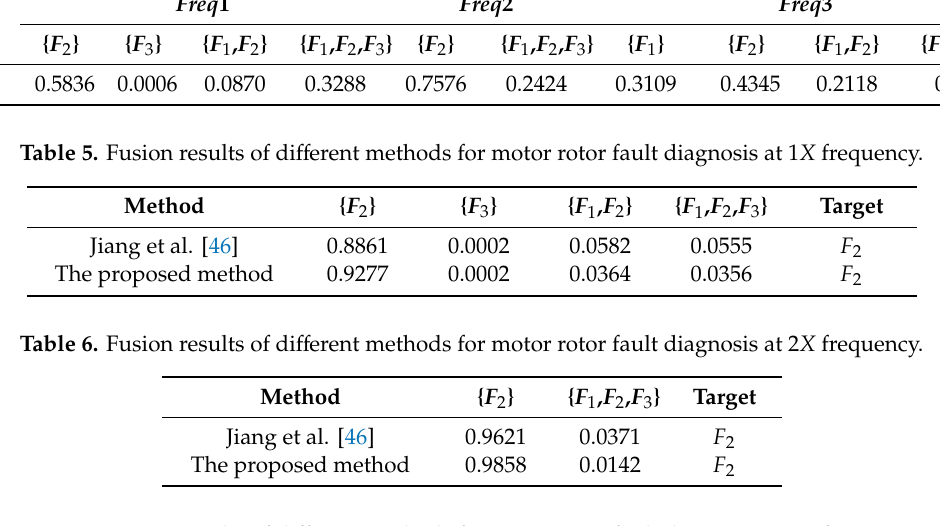
Table 7. Fusion results of di ff erent methods for motor rotor fault diagnosis at 3 X